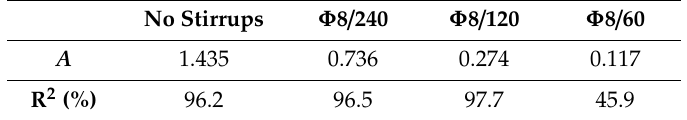
Table 2. Parameters (by regression analysis) for the exponential predictive model of bond strength loss.